Question: Name the type of graph shown.
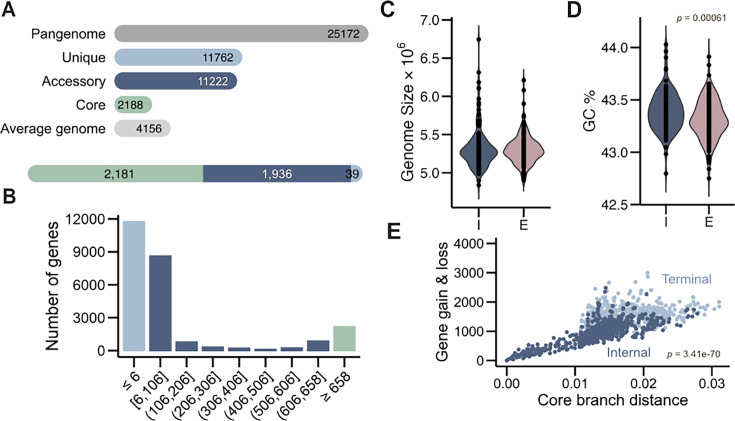
Answer: histogram